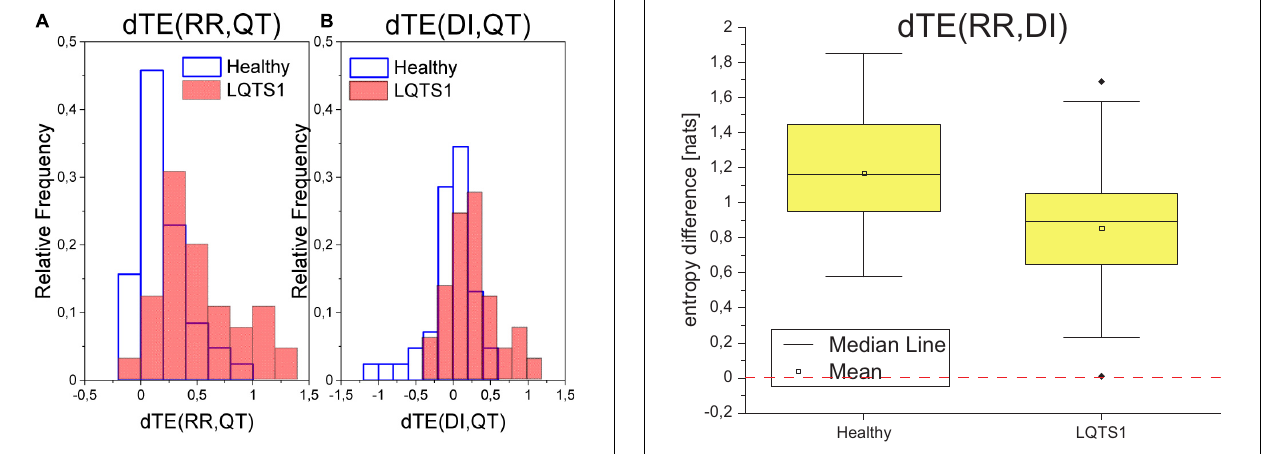
FIGURE 9 | Boxplot difference between TE in both directions for the diastolic intervals and heart rhythm (RR intervals). p -Value: 2.74318E-6.